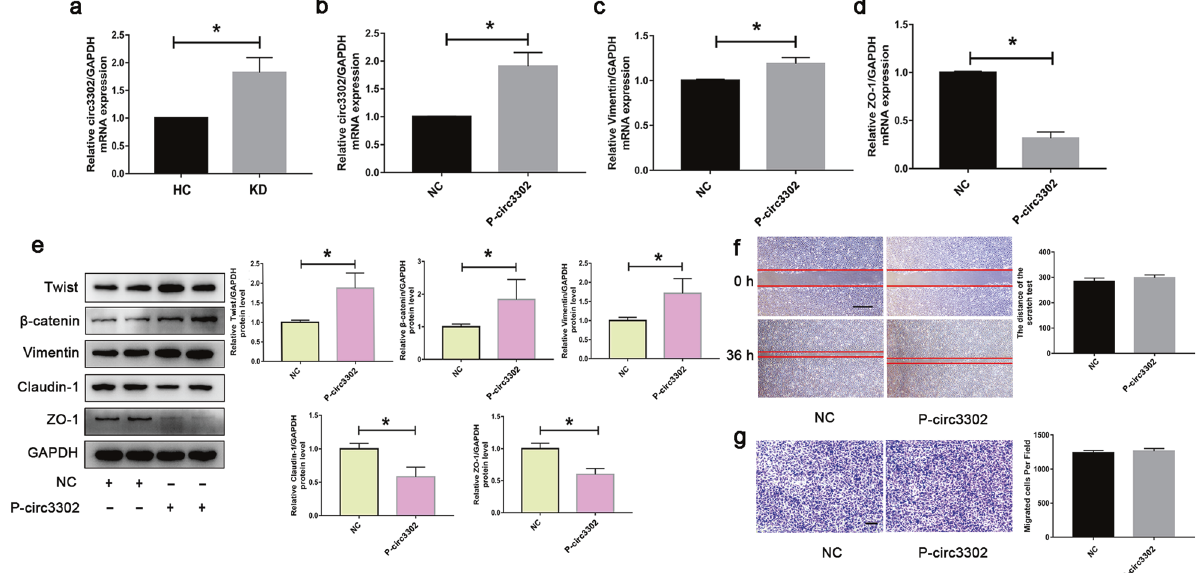
Fig. 3 Upregulation of circ3302 induced EndMT. a HUVECs were treated with medium containing 15% sera from HC ( n = 6) and KD subjects ( n = 6). After 48 h, circ3302 levels were measured by RT-qPCR analysis. b HUVECs were transfected with Plasmid-circ3302 (P-circ3302) to overexpress circ3302. c , d The mRNA levels of Vimentin and ZO-1 were determined by RT-qPCR analysis. e The protein levels of Twist, β -catenin, Vimentin, Claudin-1 and ZO-1 were determined by Western blotting. f , g Effect of circ3302 overexpression on migration was respectively evaluated by scratch and transwell assays. Magni fi cation:×40 and scale bar = 100 μ m for scratch assay. Magni fi cation:×100 and scale bar = 50 μ m for transwell assay. Data were expressed as mean ± SD ( n = 3). * P < 0.05 vs. the HC group or NC